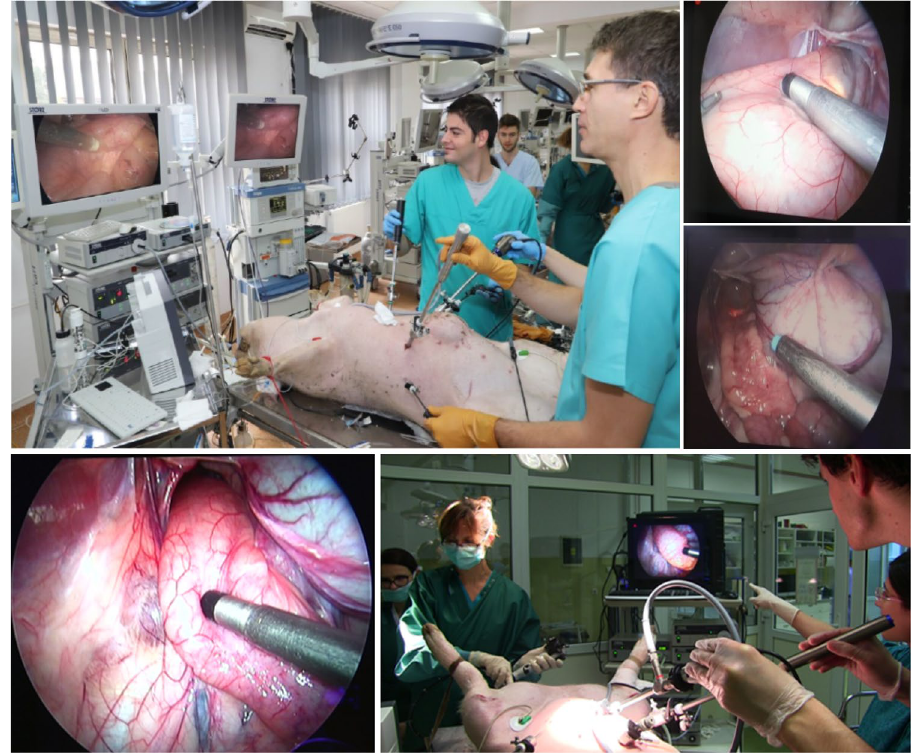
Figure 5. Combined laparoscopic and endoscopic approach to identify the position of the clip with zoom on instruments scanning clip